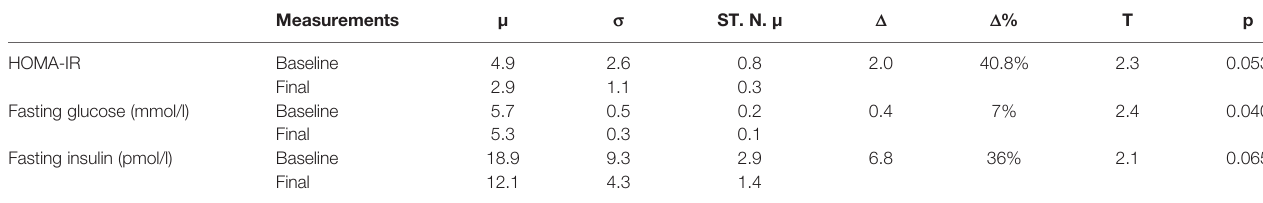
TABLE 3 | Comparison between baseline and fi nal measurements of metabolic